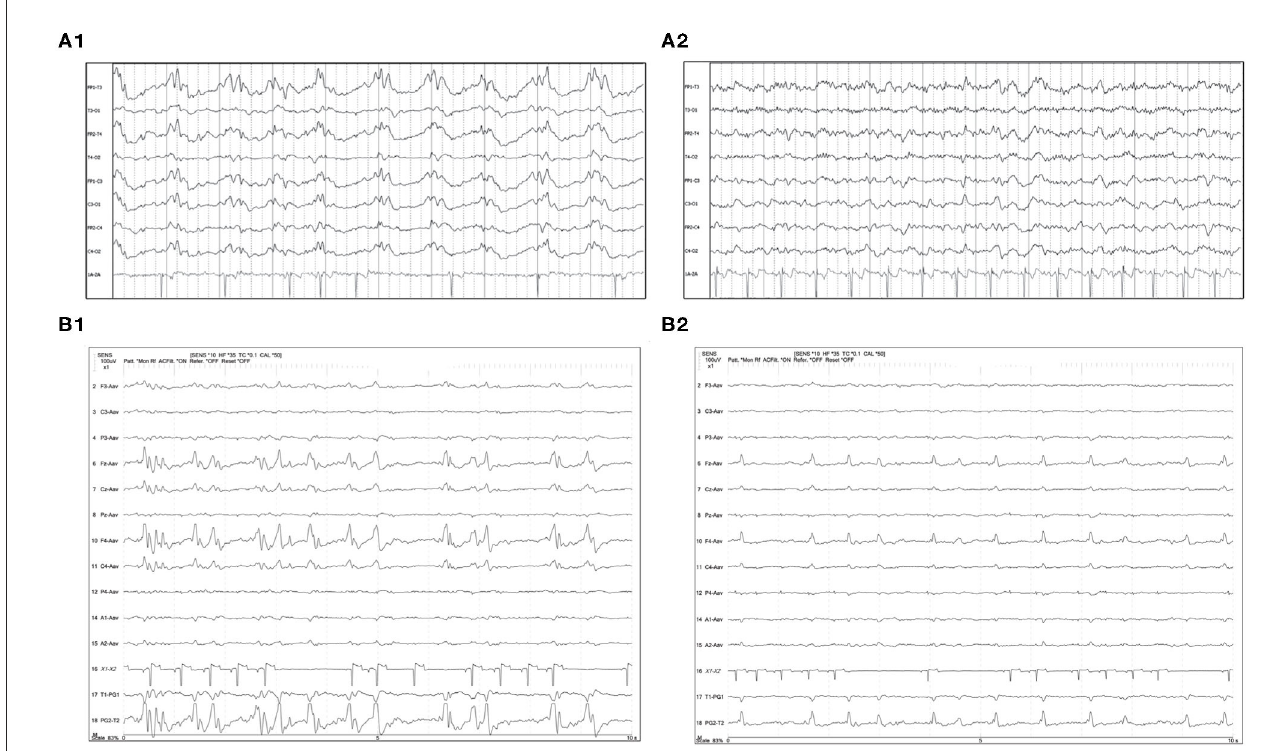
FIGURE5 Two examples of resolution (A1, A2) or apparent improvement (B1, B2) of PDs on serial EEGs. (A1) Three year old Labrador mix with cluster seizures and MUO. Polyphasic GPDs frequency about 1Hz (bipolar montage; HF 70Hz, sensitivity 3 uV/mm). (A2) Recheck EEG of the same dog (A1) on the following day showing resolution of the PDs and apparently normal EEG (bipolar montage; HF 15Hz, sensitivity 2 uV/mm). (B1) Eleven year old Miniature Pinscher with recent SE (same dog as Figure 2C). Polyphasic right frontal LPDs (referential montage; HF 35Hz, sensitivity 10 uV/mm). (B2) Recheck EEG of the same dog (B1) on the following day. The right frontal LPDs are still present, but are no longer polyphasic, and have a lower amplitude than noted in (B1) (referential montage; HF 35Hz, sensitivity 10 uV/mm). MUO, meningoencephalitis of unknown